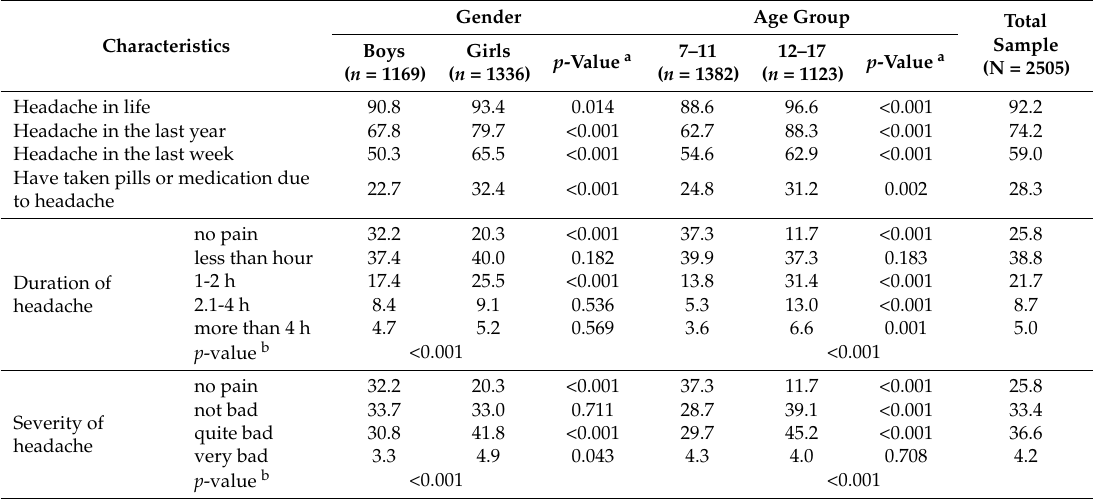
Table 2. Headache characteristics in percent, by gender and age.